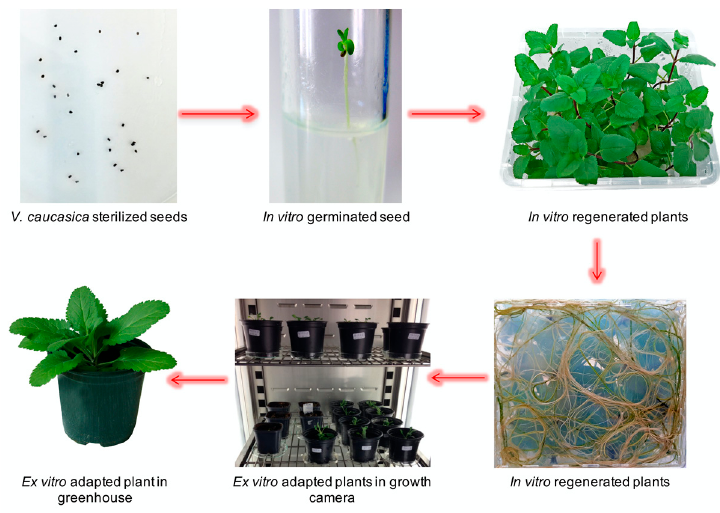
Figure 2 . Ex situ conservation of V. caucasica . Figure 2. Ex situ conservation of V. caucasica